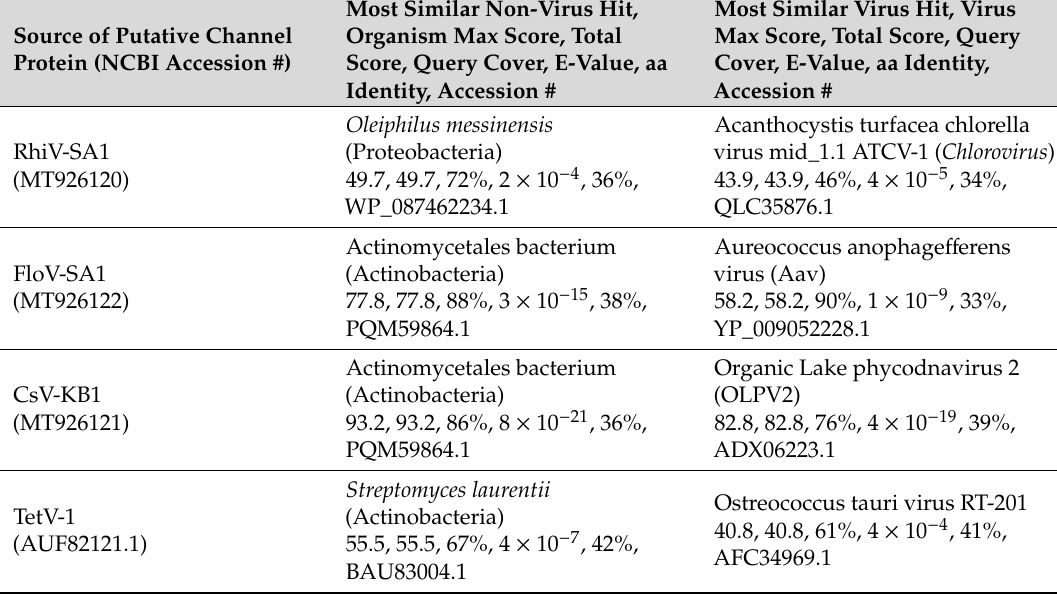
Table 1. Best non-virus and virus hits from BLAST searches of the four putative K + channel candidates from viruses in the family Mimiviridae (aa = amino